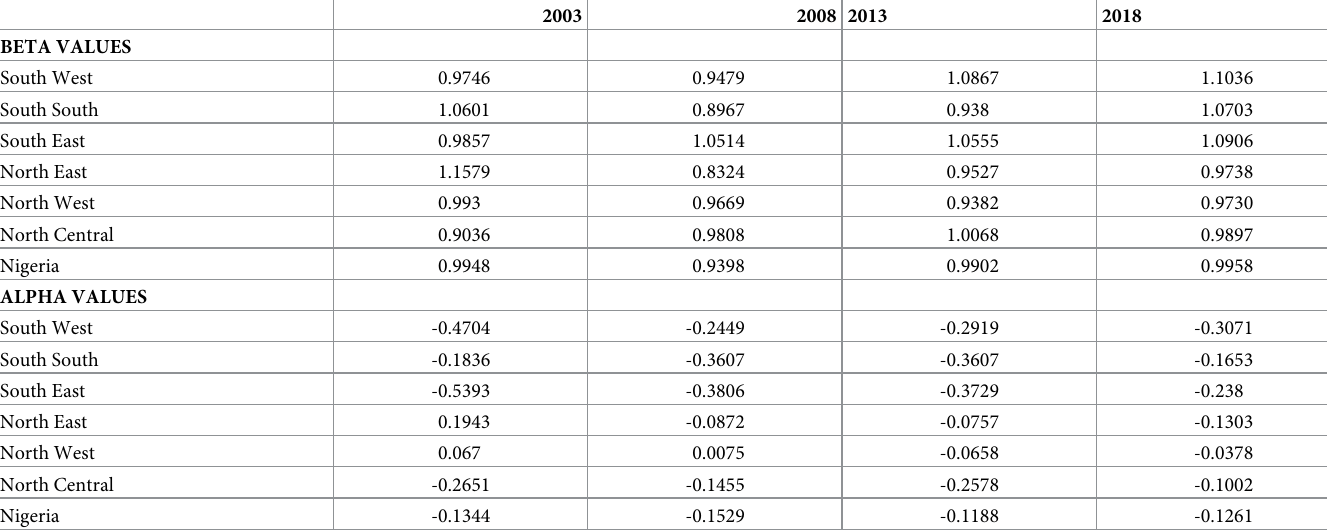
Table 3. Gompertz Parameters Regions for the Period